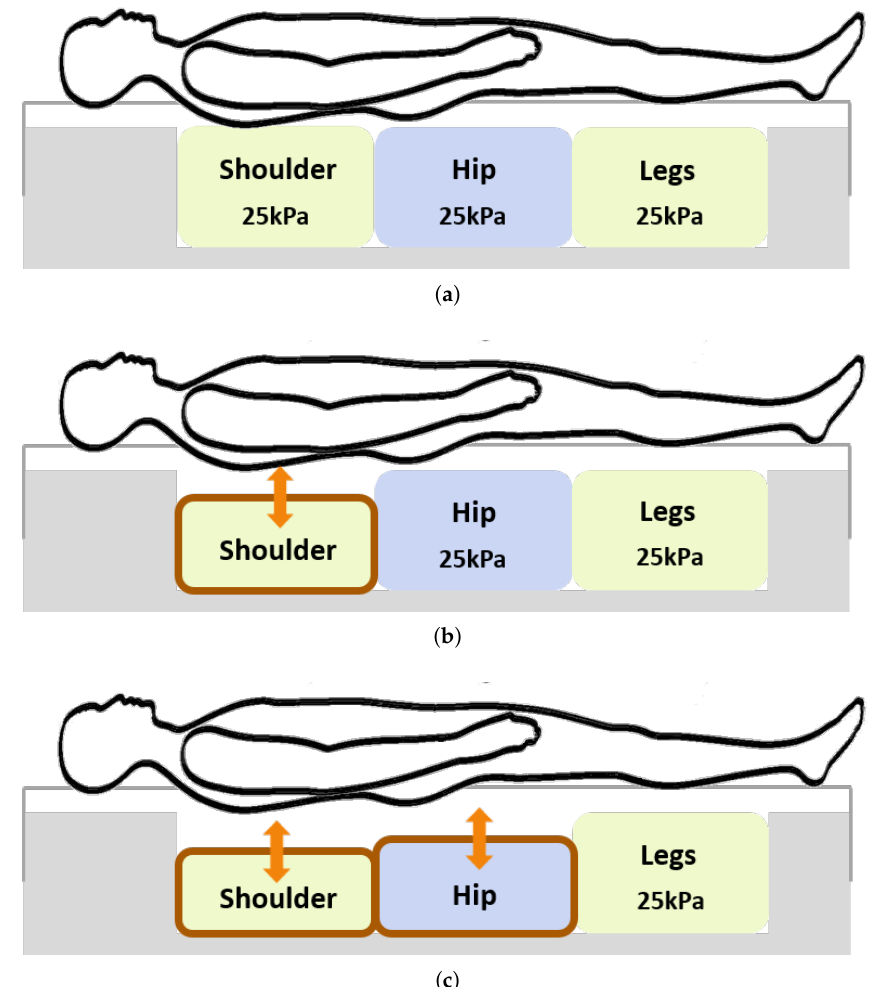
Figure 1. ( a ) Completely filled with pressure condition (A), ( b ) Shoulder customized condition (S); the customized pressure of the air cell at the shoulder was 14.2 ± 4.4 kPa and ( c ) Shoulder—hip customized condition (SH); the customized pressure of the air cell at the shoulder was 15.8 ± 6.4 kPa, and the customized pressure of the air cell at the hip was 15.2 ± 5.5